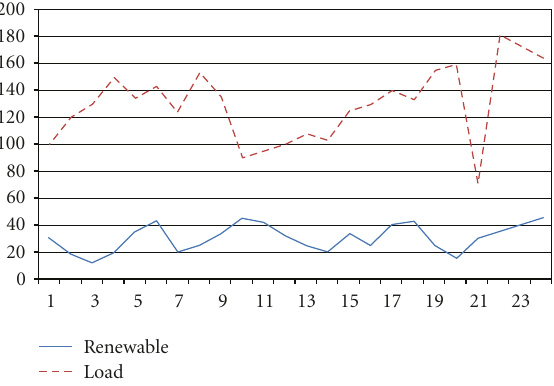
Figure 31: Forecasted load and renewable